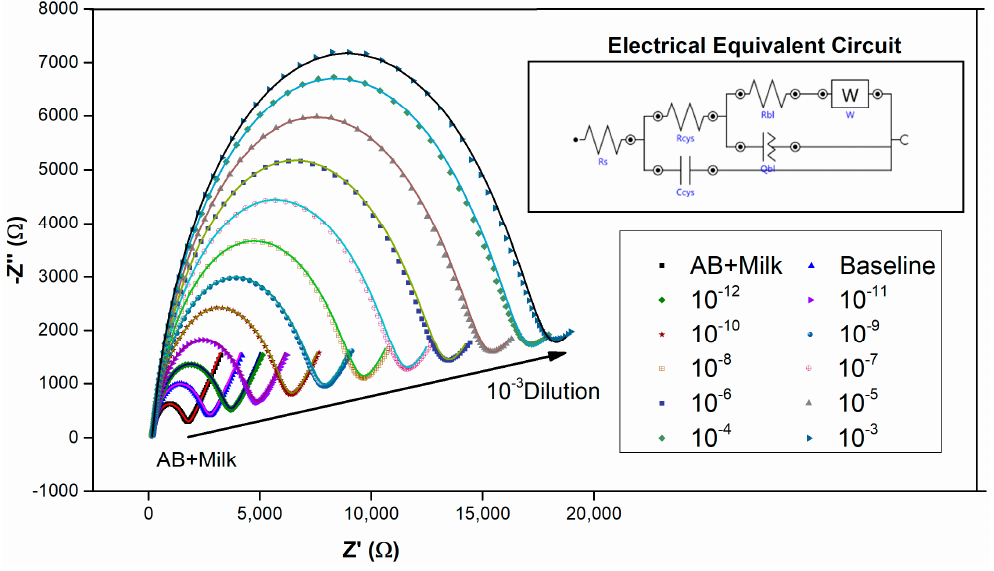
Figure 4. Electrochemical impedance spectroscopy (EIS) measurements carried out at OCP of 0.22 mV for the rabbit anti-human IgG covered surface, baseline solution (plain PBS) and increasing plasma concentrations from 10 − 12 to 10 − 3 10-fold dilutions of albumin depleted human plasma for the AD (1) case. Inset figure is the electrical equivalent circuit which was used for data fitting and the solid lines represent fitted data. R s is solution resistance, R cys and C cys are the resistance and capacitance of the cysteamine layer, R bl is resistance of the biolayer and Q bl a constant phase element representing the capacitance of the biolayer ( n > 0.7 for our data) and W is the Warburg impedance representing diffusion. EIS test parameters: AC amplitude: 10 mV, frequency range: 0.1 Hz–10 kHz. Tested in